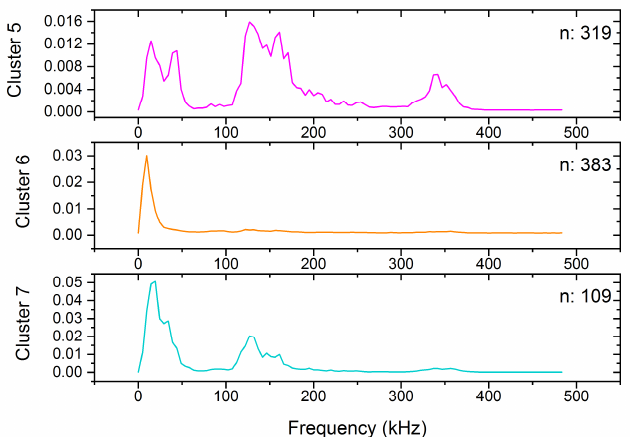
Figure 4. Energy—median frequency feature space for the measurement at 25 °C.